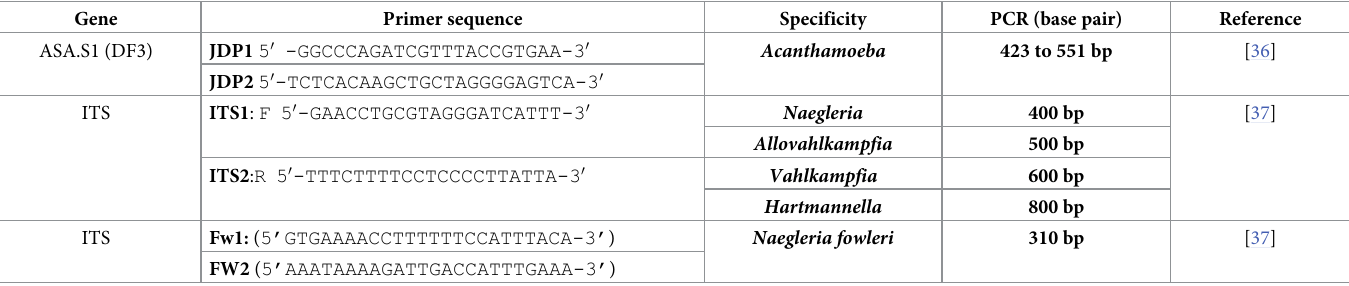
Table 1. The primers ’sequences used in PCR reaction in the present study. Gene Primer